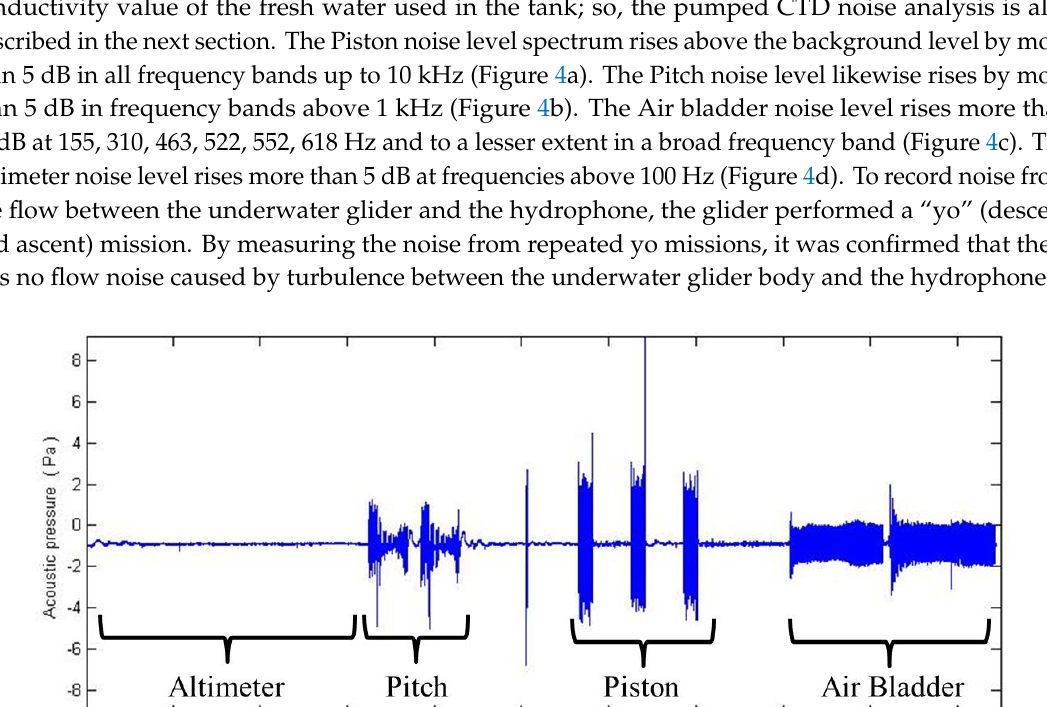
Figure 3. Recorded noise signal when the underwater glider operates in the laboratory tank.